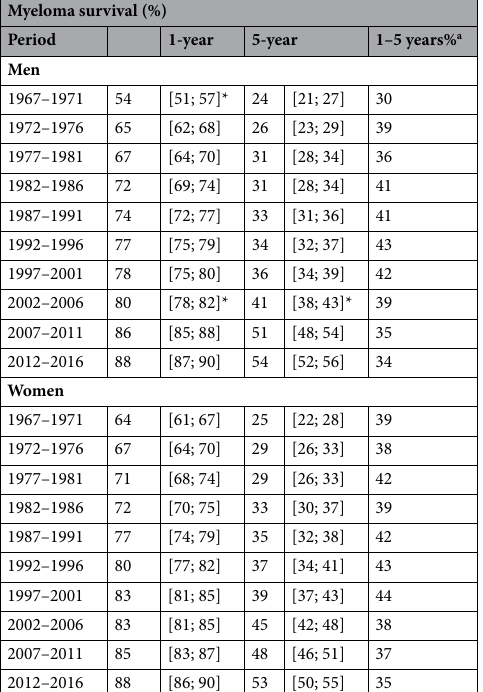
Table 2. Relative survival percent, 95% confidence intervals and survival difference between year 1 and 5 for multiple myeloma patients aged 0–89 years in Sweden 1 and 5 years after diagnosis. a 1–5 years% is the difference between survival percentages between year 1 and 5. *Indicates that the 95%CIs between periodic survival percentages do not overlap (compared to the period